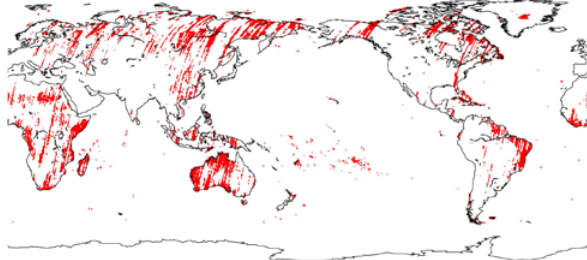
Figure 2. ASRER data acquisition requests to decrease bad pixel for GDEM version 2